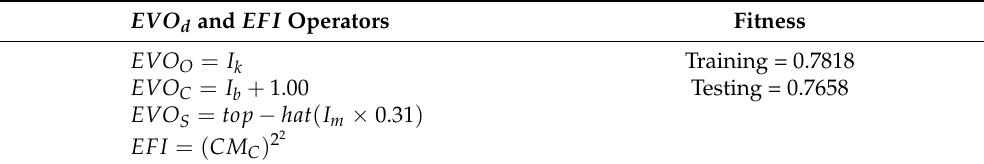
Table 4. Program structure of the operators corresponding to the best solution for the FT database. We select this solution from the 30 executions of Table 3. The final solution is simple, basically using color-chosen